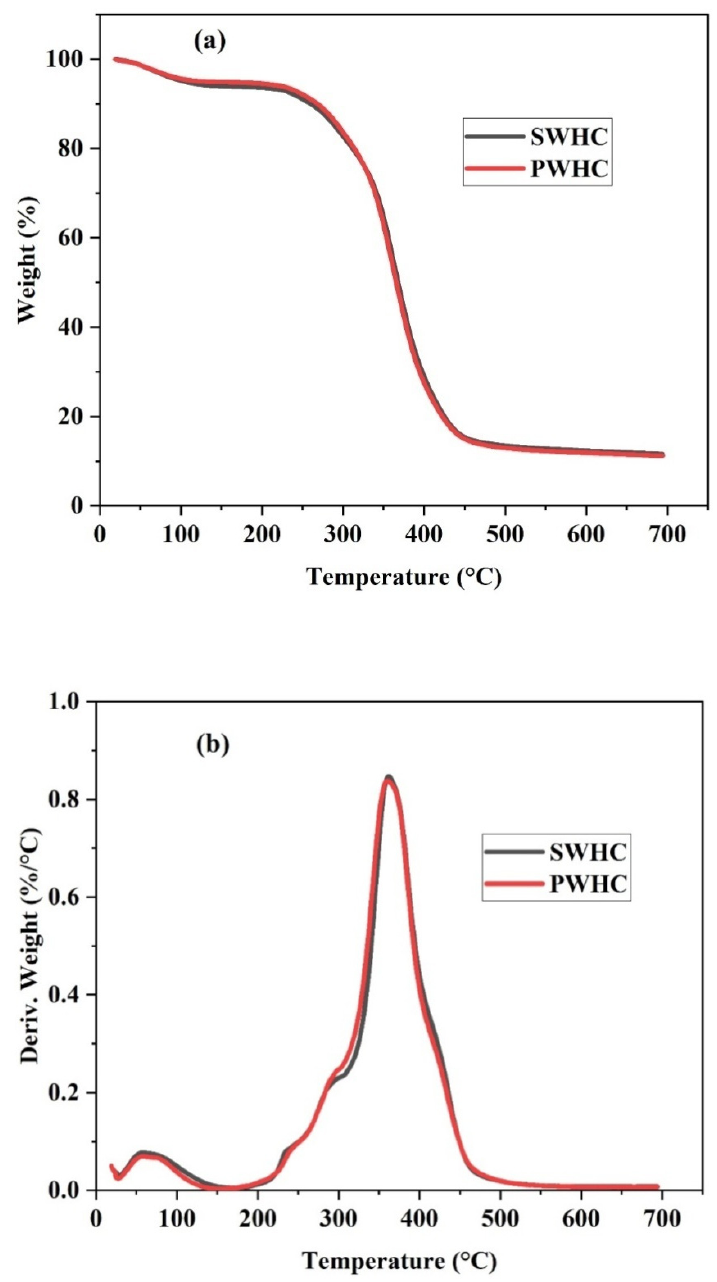
Figure 5. ( a ) TGA and ( b ) DTG curve of the SWHC and PWHC.